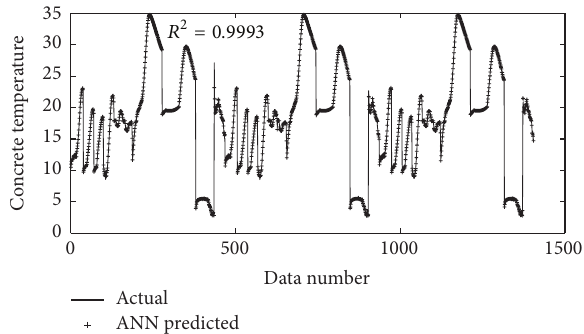
Figure 5: Graphical comparison of temperature with those pre- dicted by ANN in the training process.